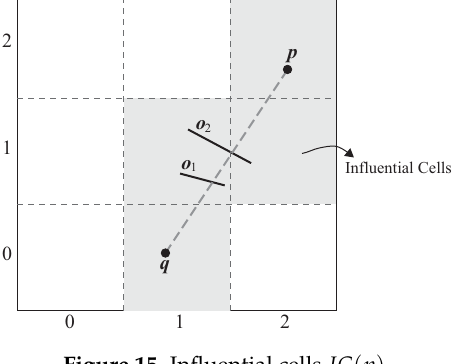
Figure 15. Influential cells IC ( p )